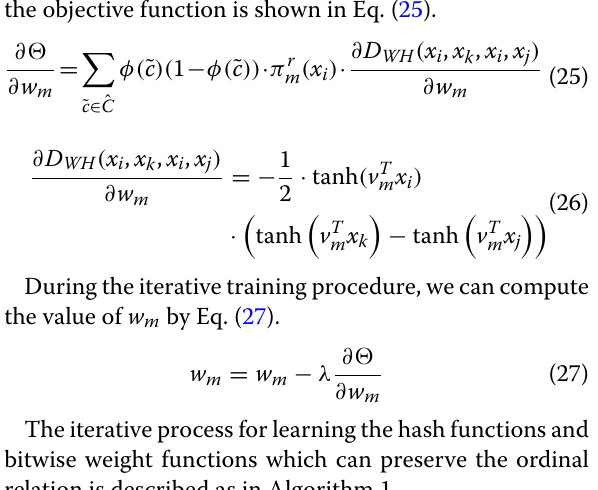
Algorithm 1 Minimal Residual Ordinal Loss Hash